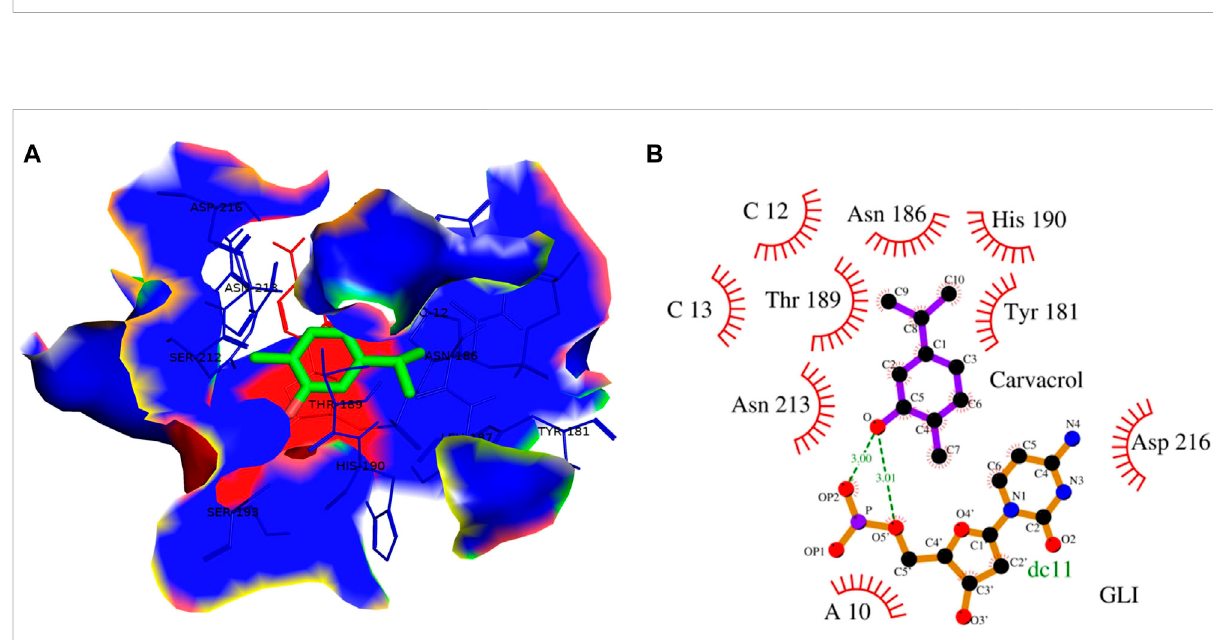
FIGURE 13 (A) 3D Interaction complex of carvacrol with GLI-DNA protein; where blue shows the hydrophobic interactions and green shows the ligand molecule (B) 2D Interaction complex of carvacrol with GLI-DNA; where red shows the hydrophobic interactions and purple shows the ligand